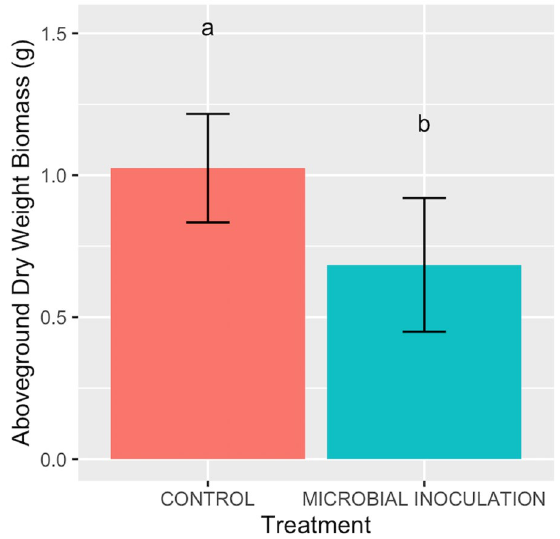
Figure 1. Total plant DW biomass of tomatoes under control and microbial inoculation treatments. Values indicate results from the combined generations. Red bars represent control treatments with no inoculation. Blue bars represent inoculated treatments. Different letters indicate significant differences at p <